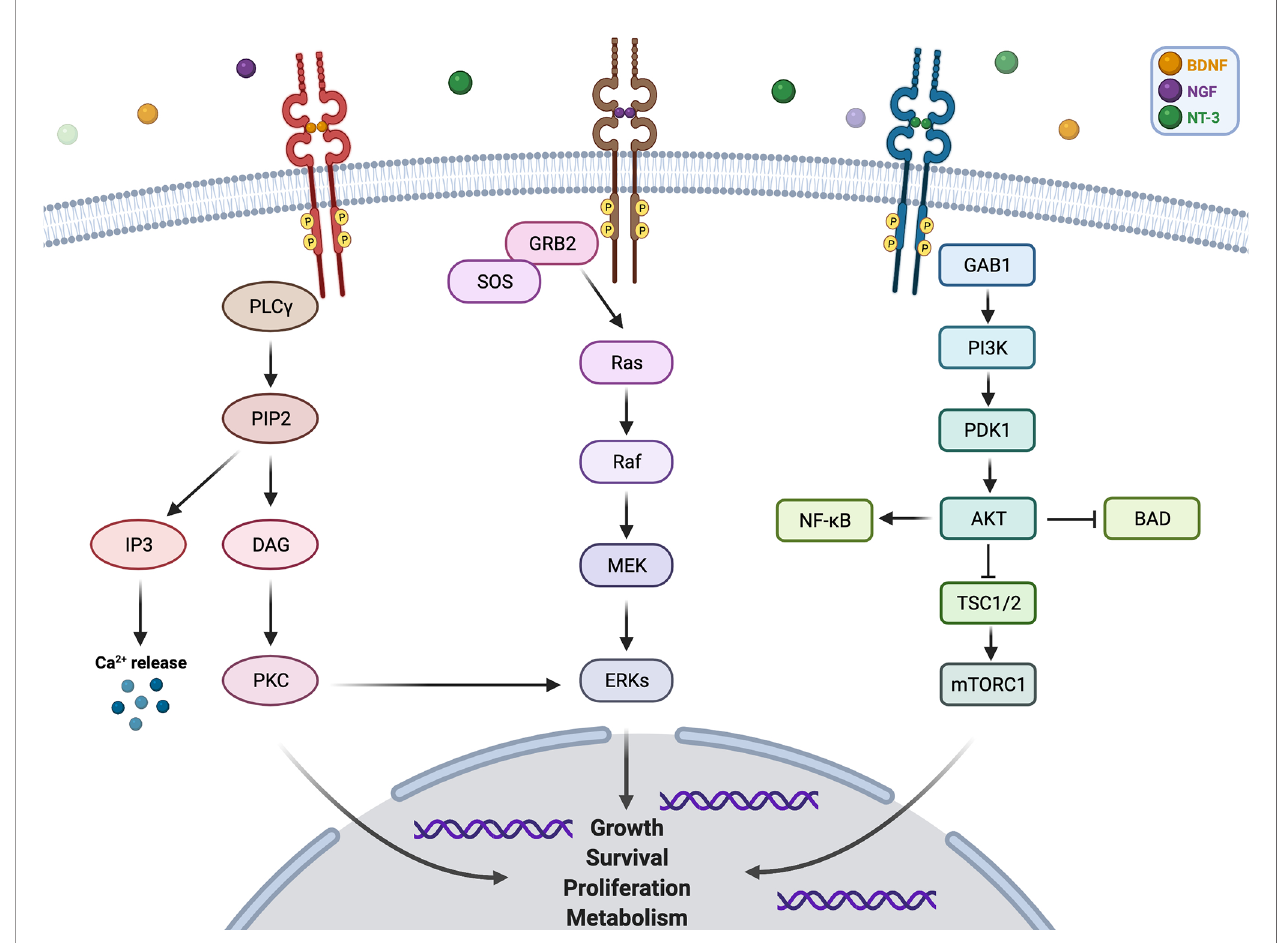
FIGURE 1 | Pathway and function of NTRK